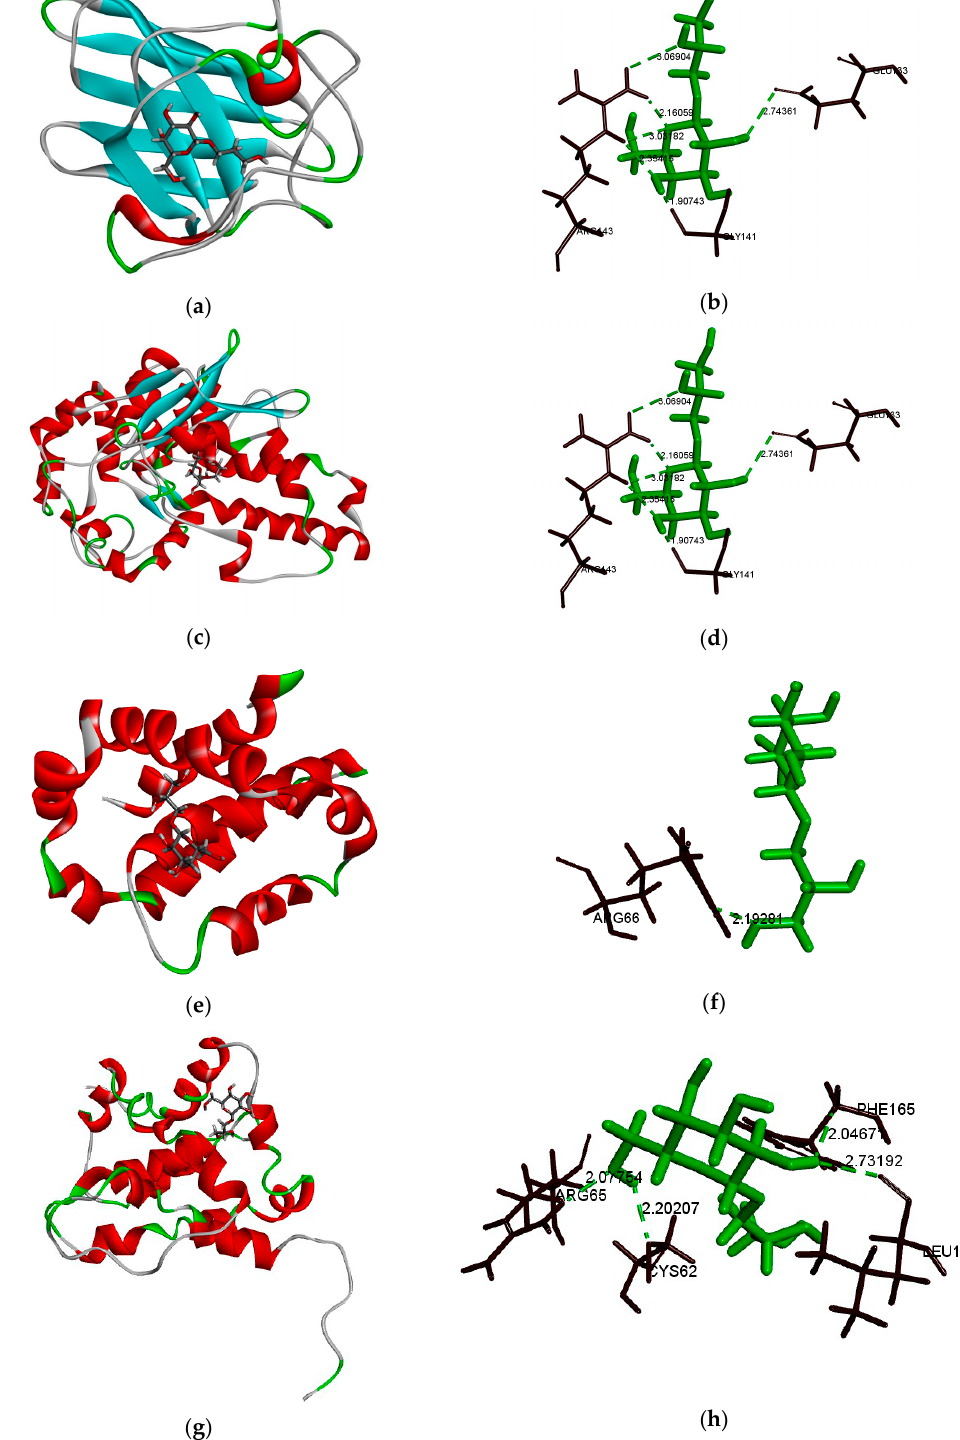
Figure 7. ( a , c , e , g ) 3D model of the interaction between DIF and SOD, GGT, bcl-2, and bax, respectively. ( b , d , f , h ) 3D model of the optimal docking structure interaction between DIF and the active site of SOD, GGT, bcl-2, and bax, respectively.